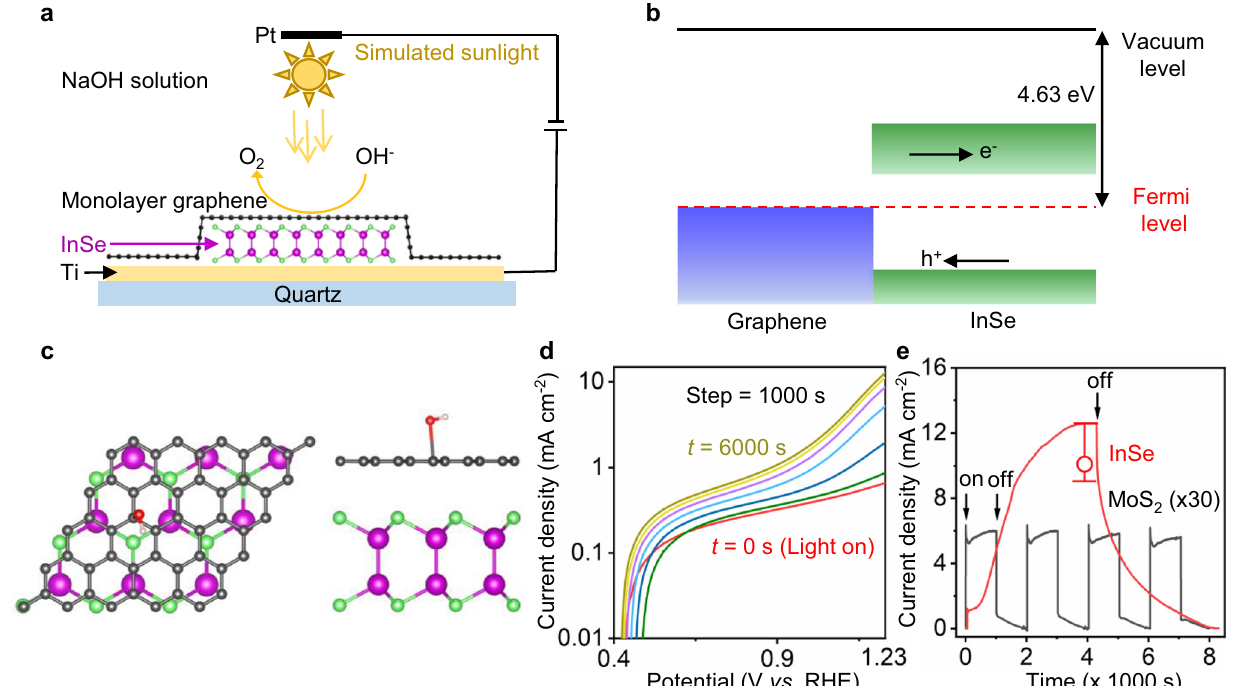
Fig. 1 InSe/Gr anode for PEC measurements. a Schematic of our experiment setup. The illumination used in this report is simulated sunlight: AM 1.5 G one-sun (100 mWcm − 2 ). b Band structure of InSe/Gr heterostructure. c DFT simulation of hydroxide species adsorption on InSe/Gr heterostructure surface. Left is the top view. Right is the side view. Red, white, gray, purple, and green balls represent oxygen, hydrogen, carbon, indium and selenium atoms, respectively. The hydroxide species adsorbs on top of the graphene carbon atom. d Linear sweep voltammetry of a representative monolayer InSe/ Gr device measured at different illumination times. The original linear-scale curves are shown in Supplementary Fig. 5. The Ti electrodes and graphene top layer have little (<1%) contribution to the measured total photocurrent (Supplementary Fig. 6). e Photocurrent density of the PEC cell as a function of the time when light was on or off. In this report, all the J – t curves are measured at a potential of 1.23 V vs. RHE. The blank dot is the saturated maximum current density averaged from 4 samples. The error bar represents the standard deviation